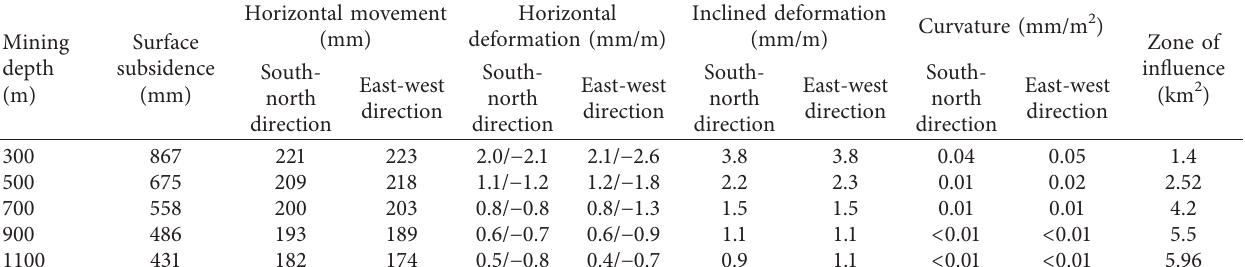
Table 3: Surface deformation characteristics affected by mining depth.